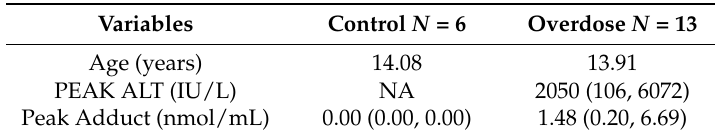
Table 1. Demographics and clinical data for control and overdose subjects. Peak